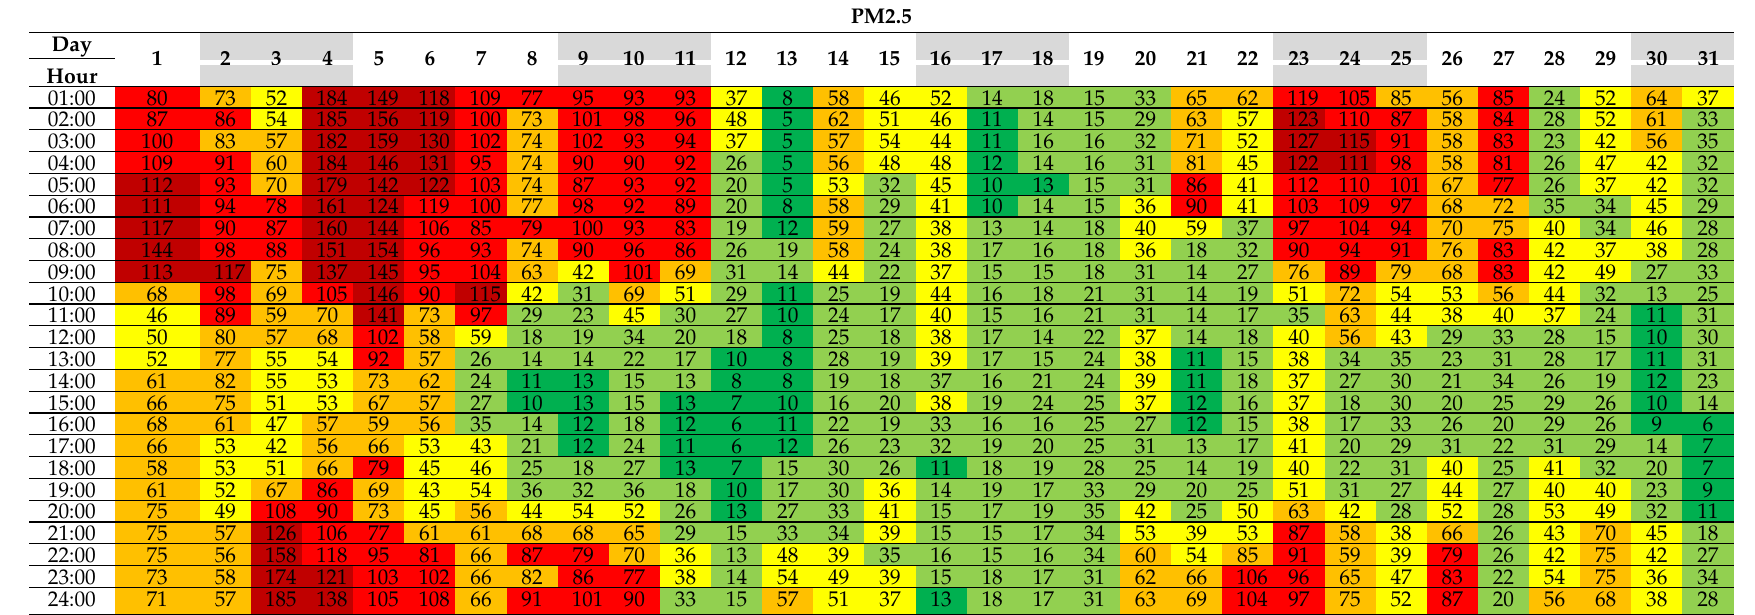
Table 1. Daily and hourly PM2.5 content changes, with the hourly Polish air quality index (AQI), average values for Krak ó w, March 2018 [39] (weekend marking in